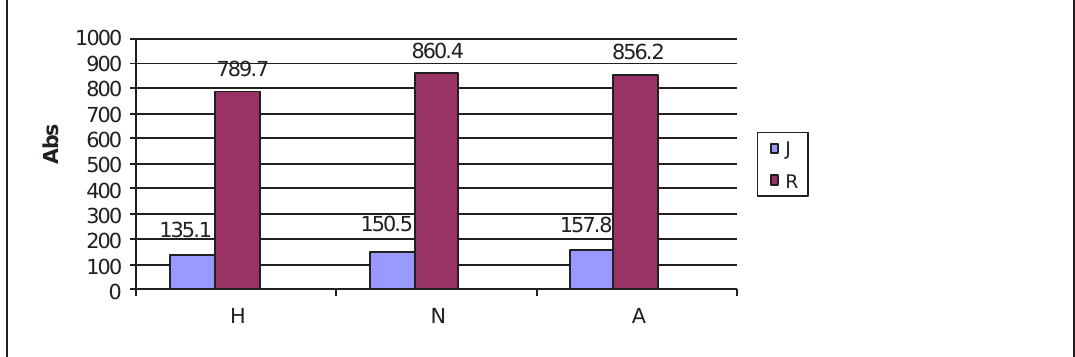
Fig. 2. The characteristic of dynamic force of girdle of inferior extremity and general endurance in students of different somatotypes: H – hypersthenics; S – sthenics; A – asthenics; J – long jump from the spot, cm; R – 5 min run, m.